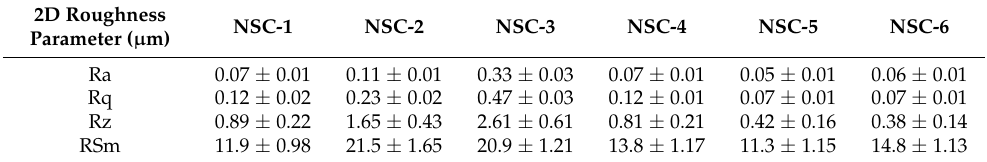
Table 2. NSC sample 2D roughness